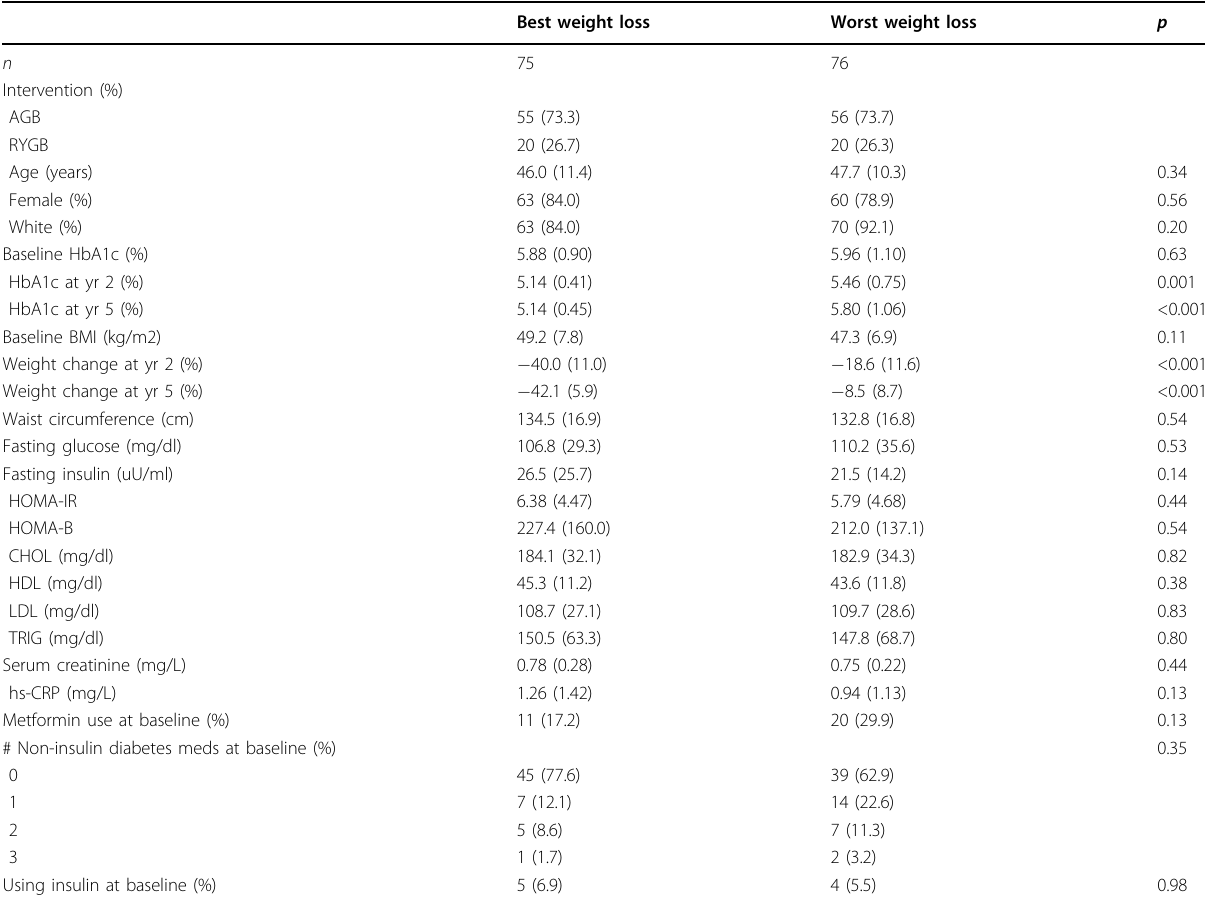
Table 2 Baseline demographics and clinical characteristics of individuals in best and worst weight loss groups (LABS study